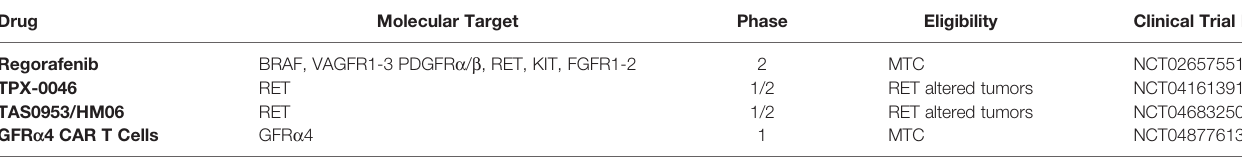
TABLE 2 | Ongoing early phase trials for patients with